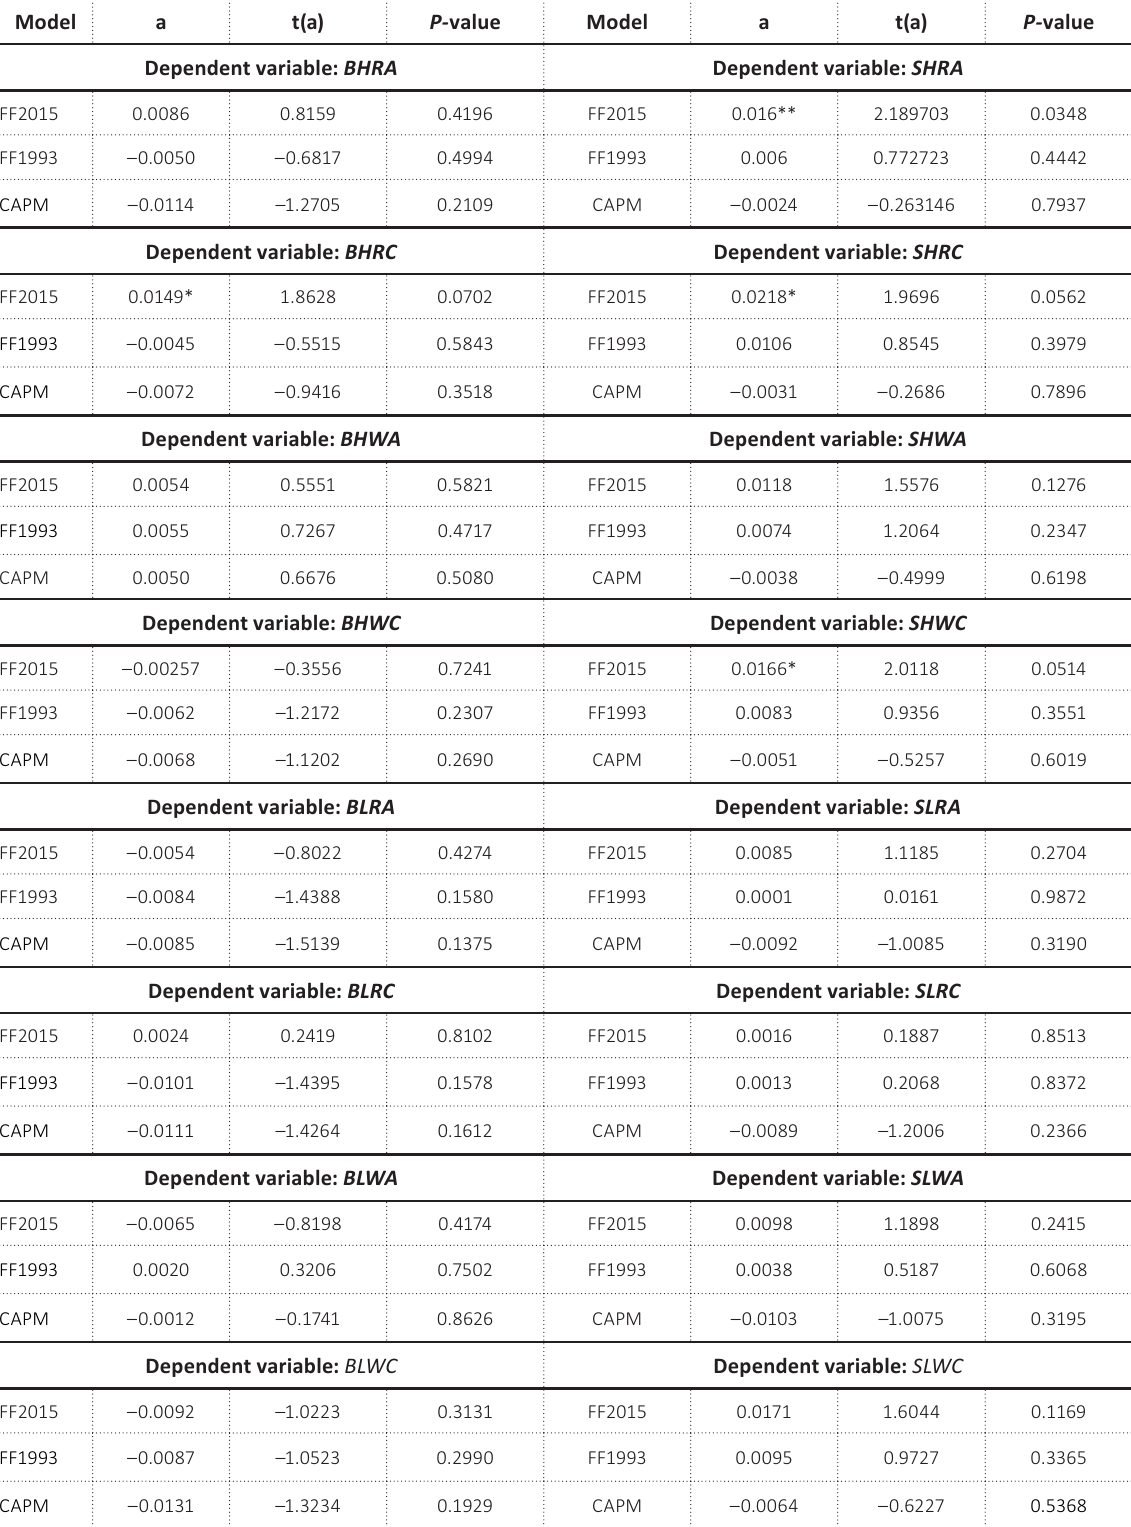
Table E1. Intercepts: 2x2 factors sort on Size and B/M, Size and OP, Size and